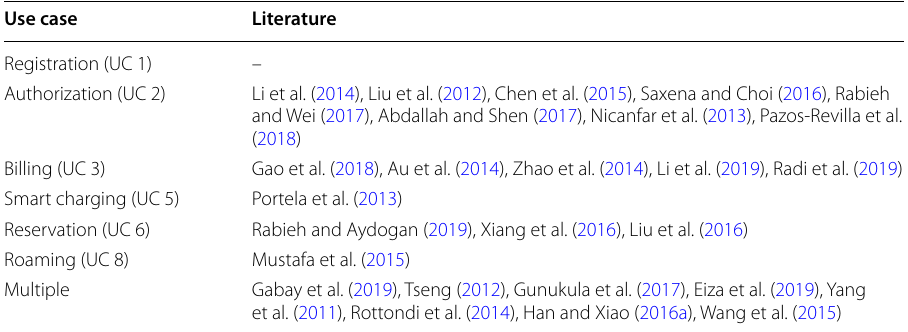
Table 1 Selection of literature per use case: For each of the relevant UCs, papers which incorporate them are listed